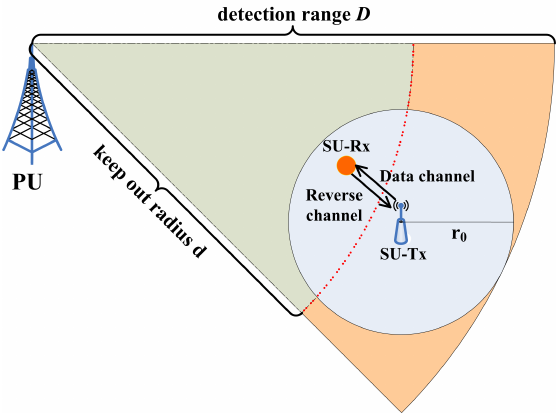
Figure 1. A scenario for CRN deployment in spectrum-heterogeneous